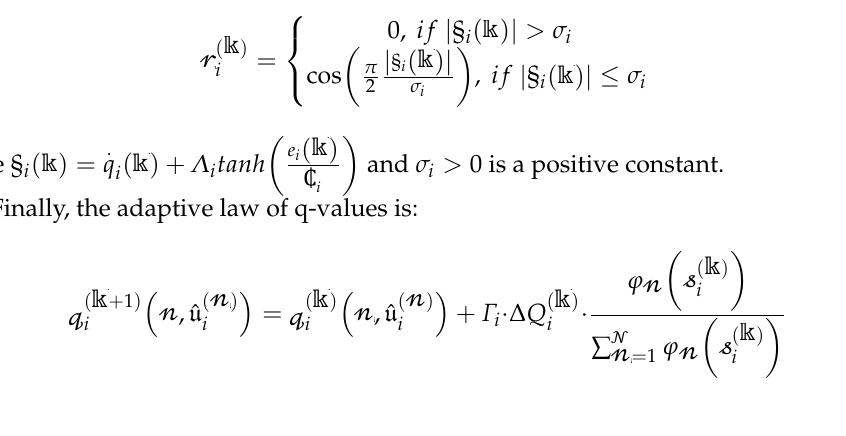
Figure 2. Membership function of fuzzy input of the 𝑖 (cid:3047)(cid:3035) subsystem. The parameters of membership function shown in Figure 2 are defined as follows: 𝐿𝑖𝑛(𝑒 (cid:3036) ) = (cid:4676)𝜁 (cid:2869),(cid:2869) ((cid:3036)) , … , 𝜁 (cid:2869),𝒶 ((cid:3036)) , … , 𝜁 (cid:2869),𝒜 ((cid:3036)) (cid:4677), 𝒶 = 1,2, … , 𝒜 (33) 𝐿𝑖𝑛(𝑞(cid:4662) (cid:3036) ) = (cid:4676)𝜁 (cid:2870),(cid:2869)((cid:3036)) , … , 𝜁 (cid:2870),𝒷((cid:3036)) , … , 𝜁 (cid:2870),ℬ((cid:3036)) (cid:4677), 𝒷 = 1,2, … , ℬ (34) where 𝒜 is the number of fuzzy sets ( 𝜁 (cid:2869),𝒶 ) for the fuzzy input 𝑒 (cid:3036) , and ℬ is the number of fuzzy sets ( 𝜁 (cid:2869),𝒷 ) for the fuzzy input 𝑞(cid:4662) (cid:3036) . The 𝓃 -th fuzzy rule in fuzzy Q learning is defined as follows: 𝑅 𝓃,(cid:3036) : IF 𝓈 (cid:2869),(cid:3036)(𝕜) is 𝐿 (cid:2869),(cid:3036)(𝕜) and 𝓈 (cid:2870),(cid:3036)(𝕜) is 𝐿 (cid:2870),(cid:3036)(𝓃) and …… and 𝓈 𝓂,(cid:3036)(𝕜) is 𝐿 𝓂,(cid:3036)(𝓃) , THEN 𝔲 (cid:3036)(𝓃) ∈ 𝔘 (cid:3036),𝓃 that 𝔲 (cid:3036)(𝓃) = 𝔲 (cid:3036),(cid:2869)(𝓃) with 𝓆 (cid:3036)((cid:3038)) (𝓃, 1) or 𝔲 (cid:3036)(𝓃) = 𝔲 (cid:3036),(cid:2870)(𝓃) with 𝓆 (cid:3036)((cid:3038)) (𝓃, 2) or 𝔲 (cid:3036)(𝓃) = 𝔲 (cid:3036),(cid:2871)(𝓃) with 𝓆 (cid:3036)((cid:3038)) (𝓃, 3) ,…., 𝔲 (cid:3036)(𝓃) = 𝔲 (cid:3036),(cid:3043)(𝓃) with 𝓆 (cid:3036)((cid:3038)) (𝓃, 𝑝) ,…., 𝔲 (cid:3036)(𝓃) = 𝔲 (cid:3036),(cid:3017)(𝓃) . with 𝓆 (cid:3036)((cid:3038)) (𝓃, 𝑃)